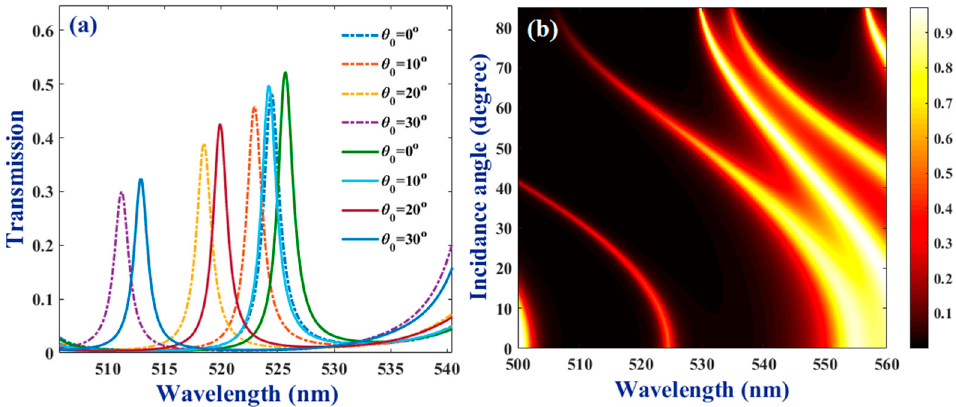
Figure 5. ( a ) Resonant modes of WBC (dashed lines) and RBC (solid lines) samples at different light incident angles of θ = 0, 10, 20, and 30°; ( b ) colormap of transmittance versus wavelength for incident angles of 0–85°. The thickness of the air layer is 80 nm and other parameters are considered, as presented in the caption of Figure 2.